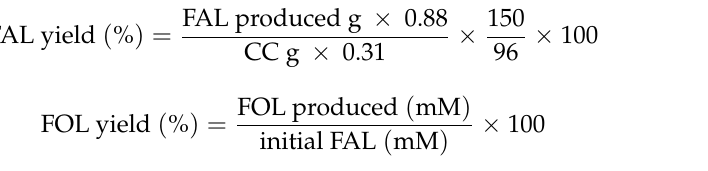
Figure S2: The HPLC image of FAL liquor after